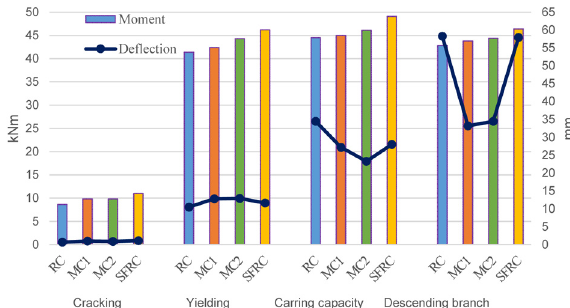
Fig. 5. Comparison of moments and deflections of all beam types tested